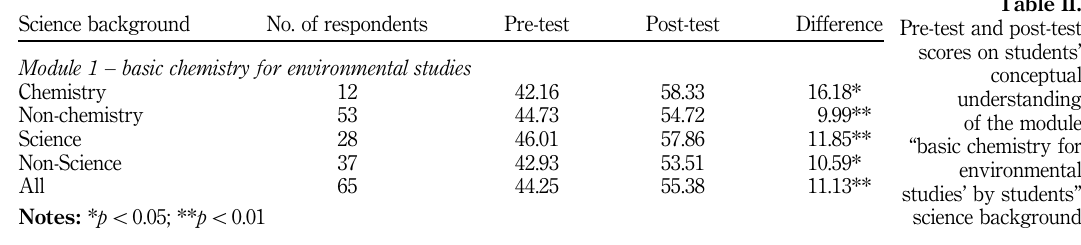
Table II. Pre-test and post-test